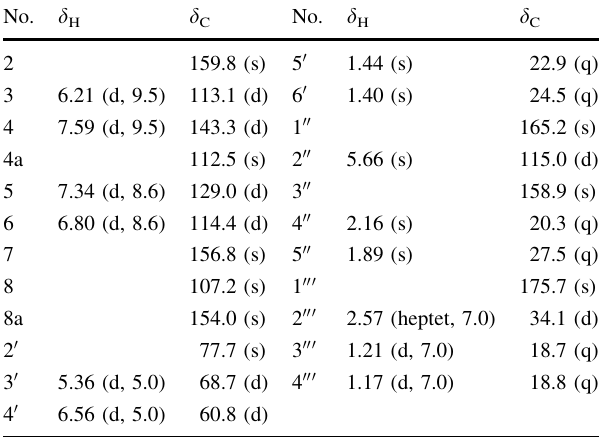
Table 2 NMR spectroscopic data for 4 0 - O -isobutyroylpeguangxienin